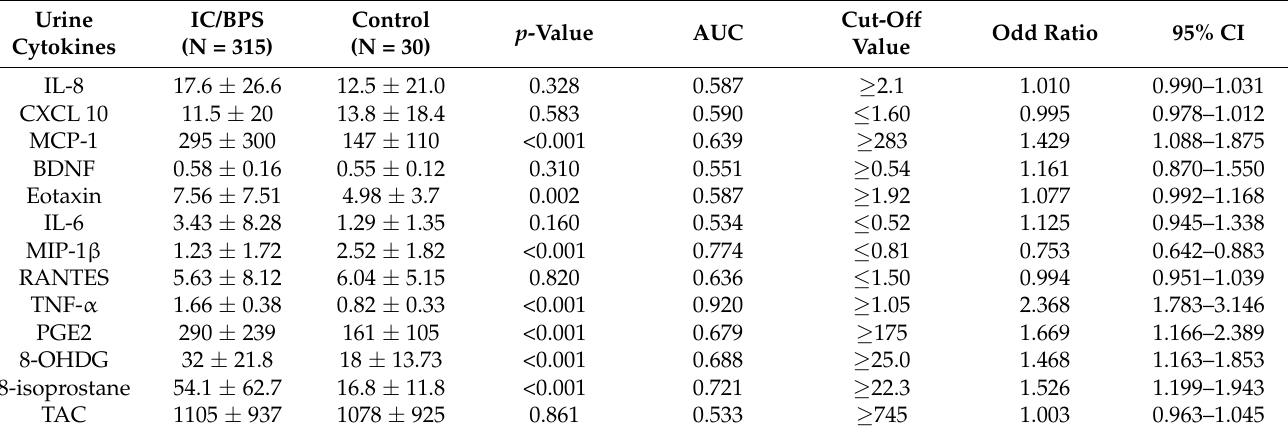
Table 1. The levels of urine biomarkers in patients with interstitial cystitis and normal